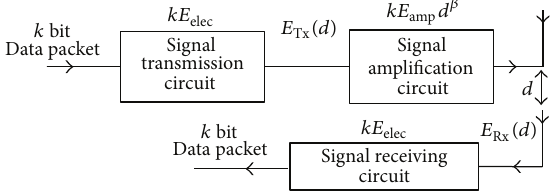
Figure 2: The first-order energy